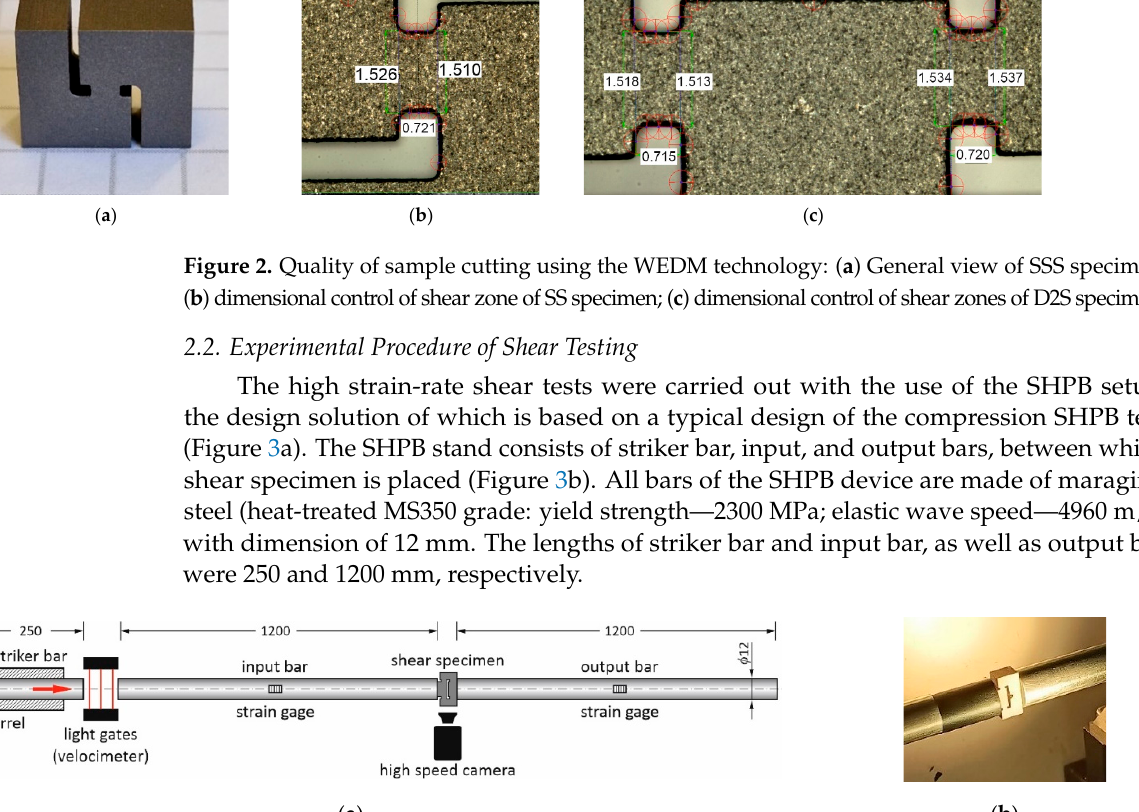
Figure 3. Scheme of the SHSB setup used in investigations ( a ); view of the D2S specimen placed between the SHPB bars ( b ).